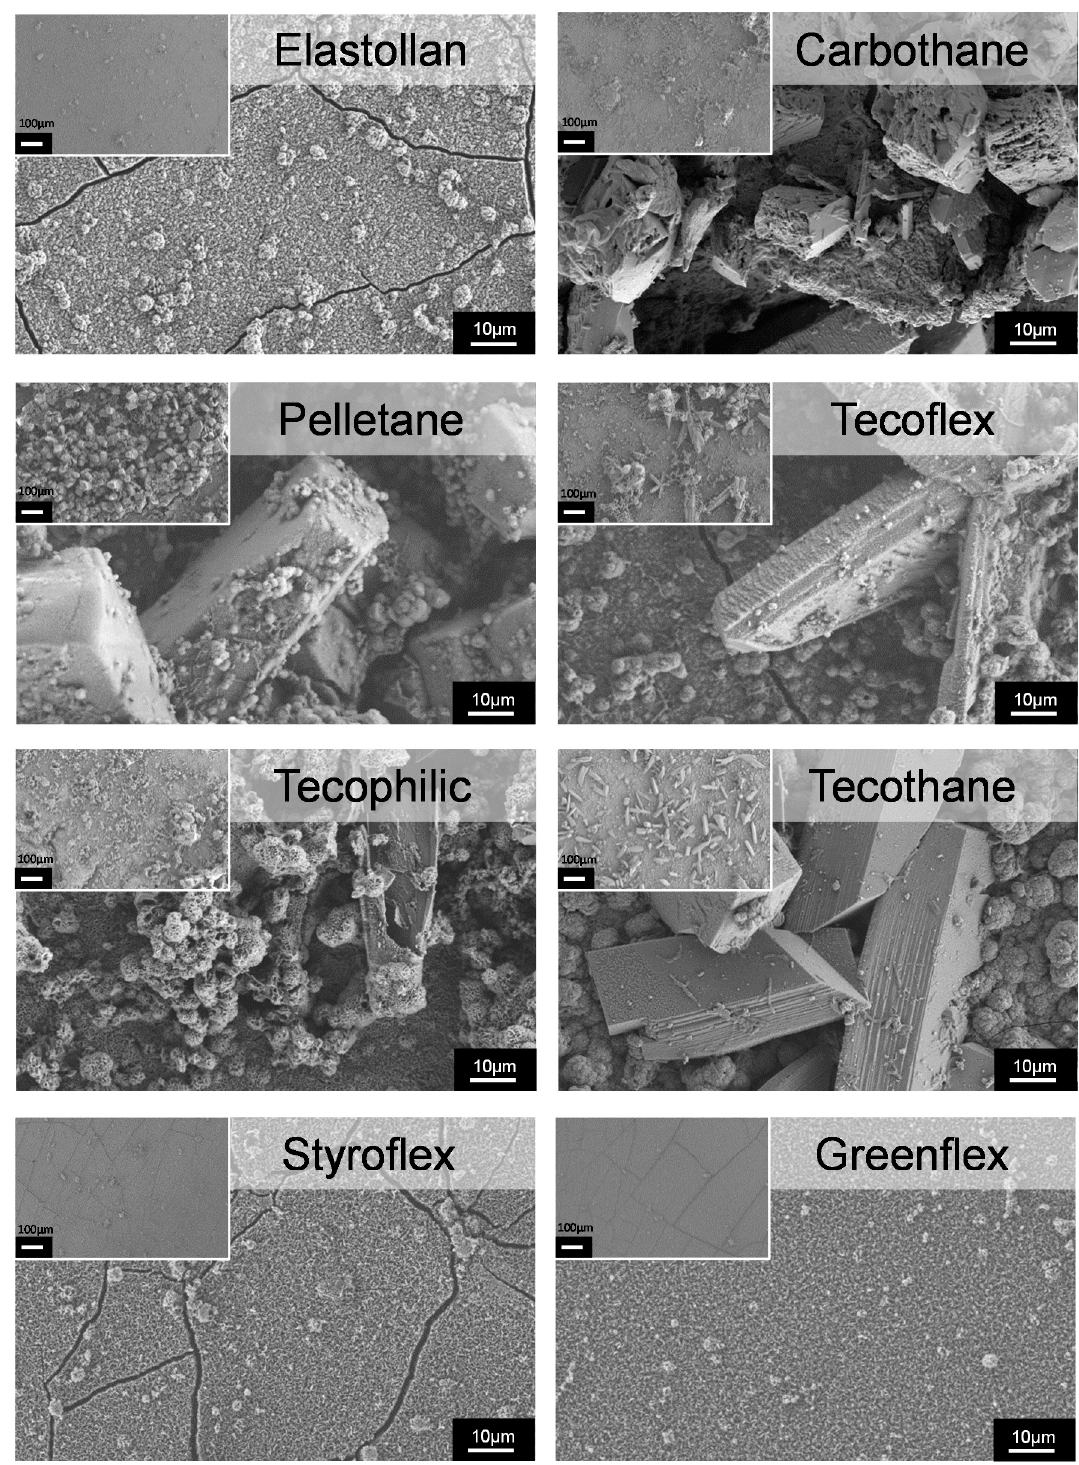
Figure 5. SEM images of encrusted polymer surfaces after 5 d in the in vitro encrustation system. Note the mix of amorphous depositions and clear-cut crystals. The surface of Elastollan, Styroflex, and Greenflex is covered by only a thin layer of amorphous depositions, whereby nearly no large crystals are present. The other polymers (Carbothane, Pelletane, Tecoflex, Thecophilic, Tecothane) show large crystalline depositions on the surface (bar 10 µm, bar insert 100 µm; FESEM Merlin, Zeiss). It was found that the three polymers with the lowest encrustation mass (Styroflex, Elastollan, and Greenflex) showed very smooth depositions resembling a cauliflower-like morphology. Large areas of the samples were covered almost exclusively with this smooth film of crystallites. Only very